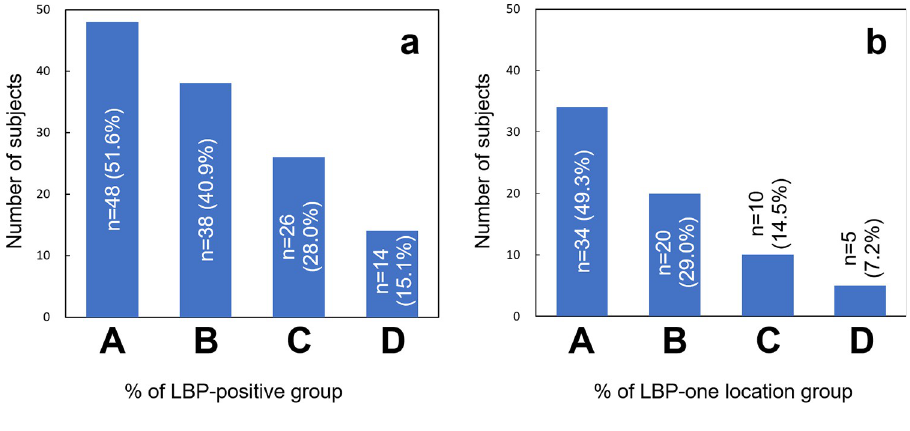
Fig 2. Location of low back pain. a: Number of subjects in LBP-positive group; b: Number of subjects in LBP-one location group. LBP: Low back pain; A. midline of the lumbar region, B. paravertebral muscles, C. upper buttock, and D. sacroiliac